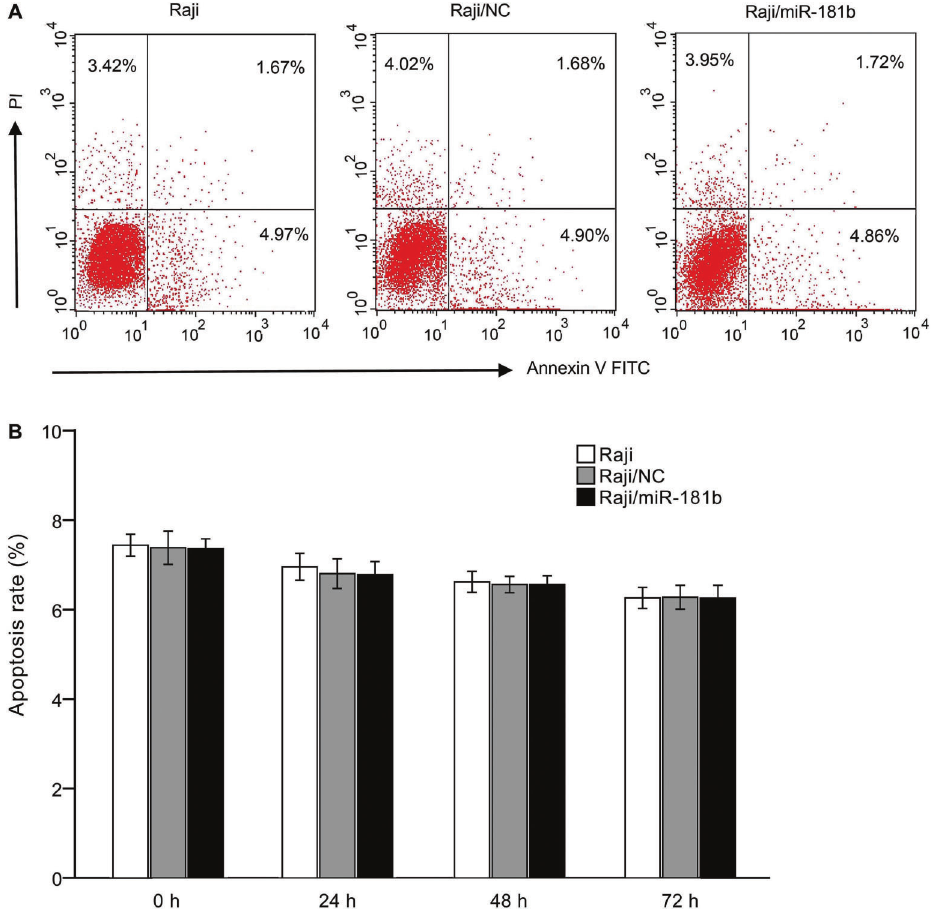
Figure 9. Effect of miR-181b transfection on Raji cell apoptosis. A , Flow cytometry apoptosis scatter diagram after transfection for 48 h. B , After transfection for 0, 24, 48, and 72 h, total apoptosis rates (early apoptosis and late apoptosis) had no obvious changes in Raji/ miR-181b group compared with control groups (Raji and Raji/NC) (P 4 0.05, ANOVA). Data are reported as means ± SD